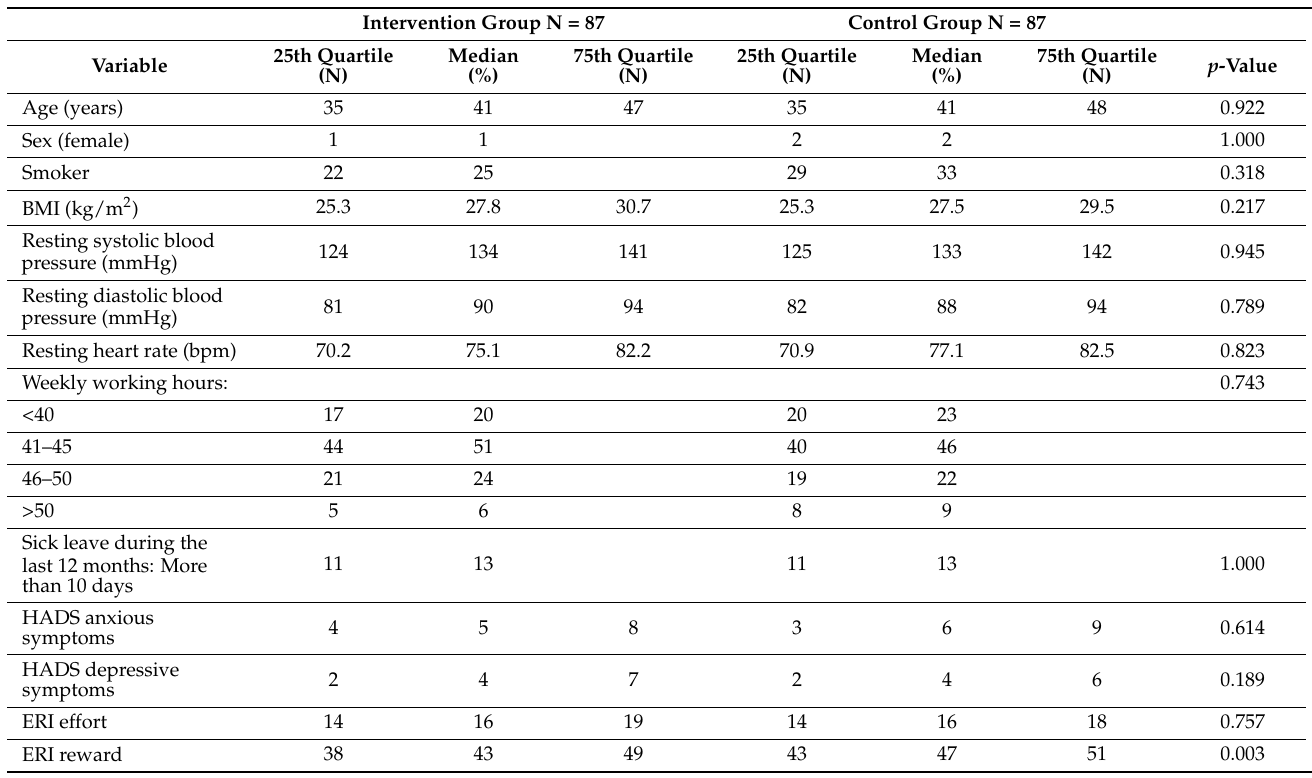
Table 1. The characteristics of the study